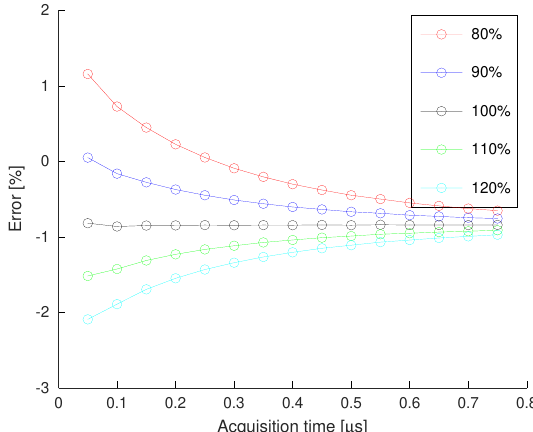
Figure 13. Voltage error for several V SH 0